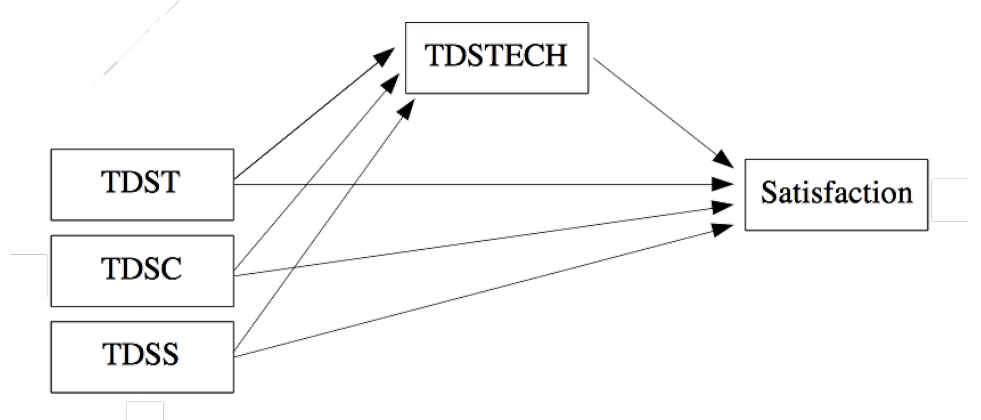
Figure 1 . Conceptual mediation model to be